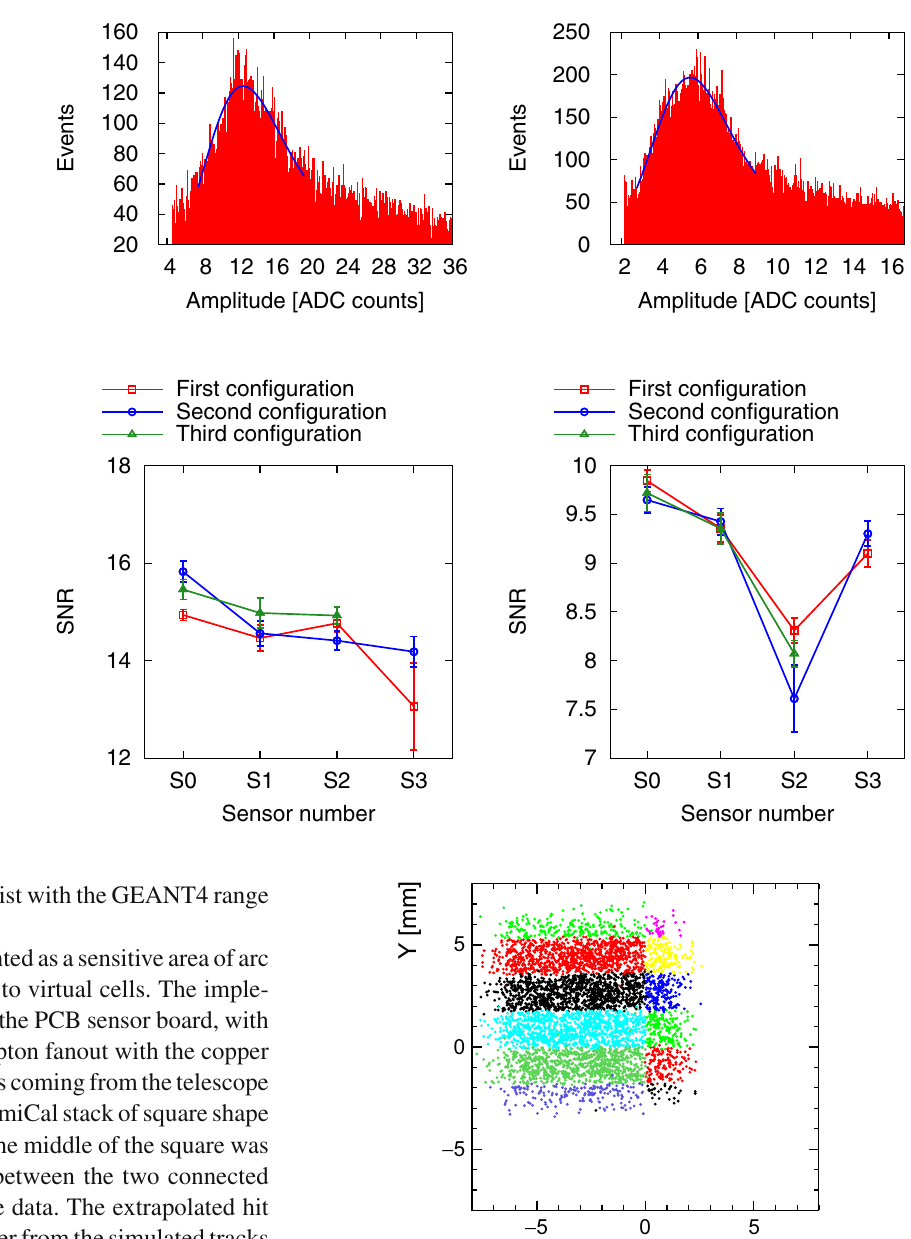
Fig. 17 In the MC simulation, distribution of the extrapolated hit posi- tion in the first layer of LumiCal, with a color code determined by the pad number where the energy was deposited